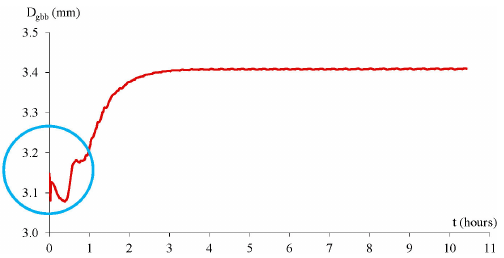
Figure 9. Temporal variation of the geometric mean diameter of the bedload at the brinkpoint. The blue oval indicates the initial nu- merical adjustment of the model, mostly related to the development of a coarse mobile active